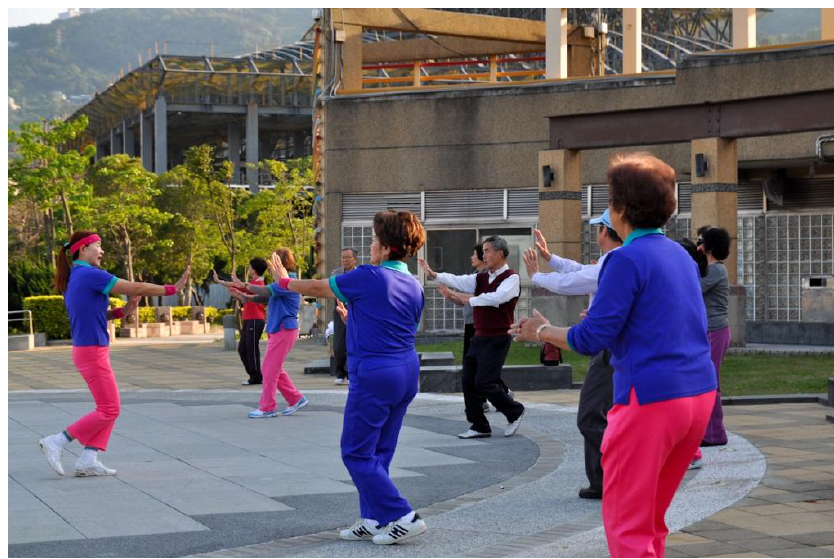
Figure 1. Example of Tai Chi class in a Taipei green